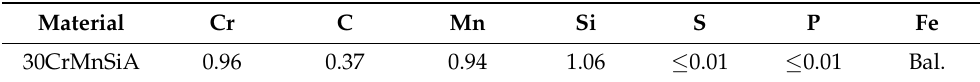
Table 1. Chemical composition of 30CrMnSiA Steel (wt. %).